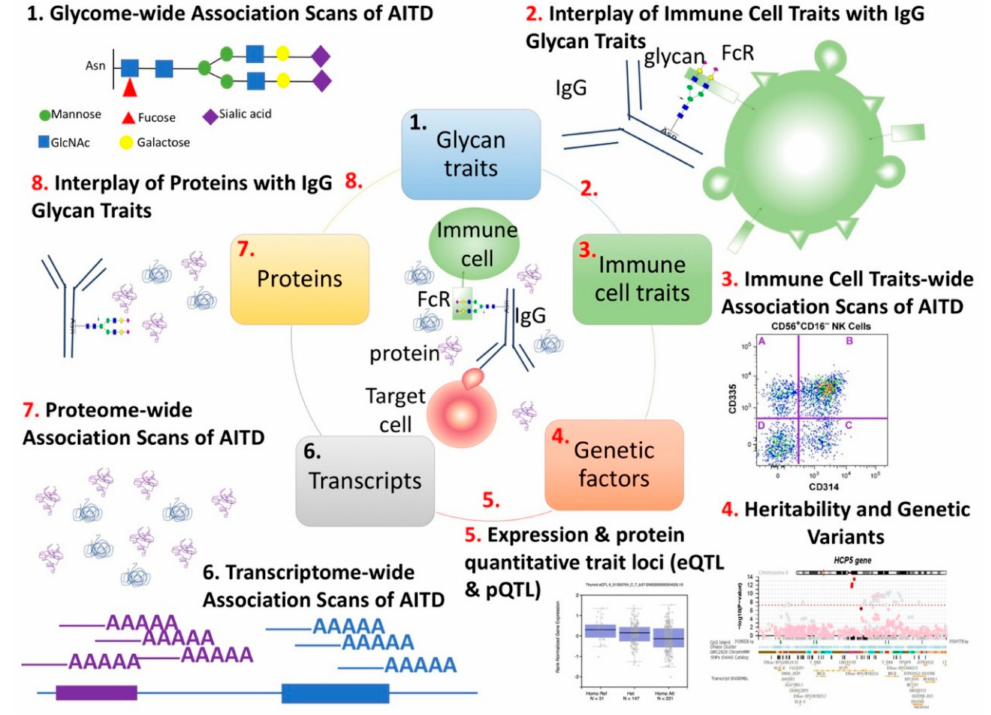
Figure 1. Multi-omics computational analyses were used to study the components of antigen / antibody / e ff ector cell complex structure in AITD. (1) We previously performed glycome-wide association studies of AITD and TPOAb levels using 3146 individuals from three European cohorts, including the TwinsUK cohort. We identified 17 AITD-IgG N-glycan traits in the discovery TwinsUK cohort, and seven of these 17 have been then replicated in two other cohorts [4]. (2) In the present study, we studied the association of total IgG N-glycan traits with 23,485 immune cell traits in 383 individuals from the TwinsUK cohort (regardless of disease status). We showed that 6 out of the 17 AITD-IgG glycan traits were correlated with 51 immune cell traits featuring the CD335, CD134, and CD158b receptors. (3) None of these 51 immune cell traits appeared to be associated with AITD in 374 individuals (34 with AITD). (4) The heritability of AITD, TPOAb level and several - omic features (IgG N-glycan traits and immune cell traits) were performed in previous studies of the TwinsUK cohort [4,27–29]. Here we estimated the heritability of secreted proteins, but we could not determine shared additive genetic variance between di ff erent phenotypes studied (AITD status, TPOAb level, level of IgG N-glycan traits, of immune cell traits and of circulating proteins in the bloodstream). (5) We identified genetic variants that alter the expression of genes, proteins and cell-bound immune receptors (highlighted in this study) using the previous GWASs performed in the TwinsUK cohort or from GWAS catalog, eQTLs from GTEx project and pQTLs from INTERVAL project [27,28,30–35]. (6) We previously performed transcriptome-wide association studies of AITD, TPOAb level, and N-glycan structures in the whole blood of approximately 300 individuals and we found no significant associations [4]. (7) We observed 3 out of 1113 circulating proteins tested in plasma of almost 300 individuals shown to be associated with AITD status (TSH, Caspase-2, and Interleukin-1 α ). (8) Several secreted proteins were correlated with the level of plasma IgG glycan traits in 164 individuals, but none of them were also associated with AITD. The sample sizes of these di ff erent studies are described in Table S1. GlcNAc = N-acetylglucosamine. The numbers in black depict analyses performed previously [4,27–29] while the numbers in red depict analyses presented for the first time in the present